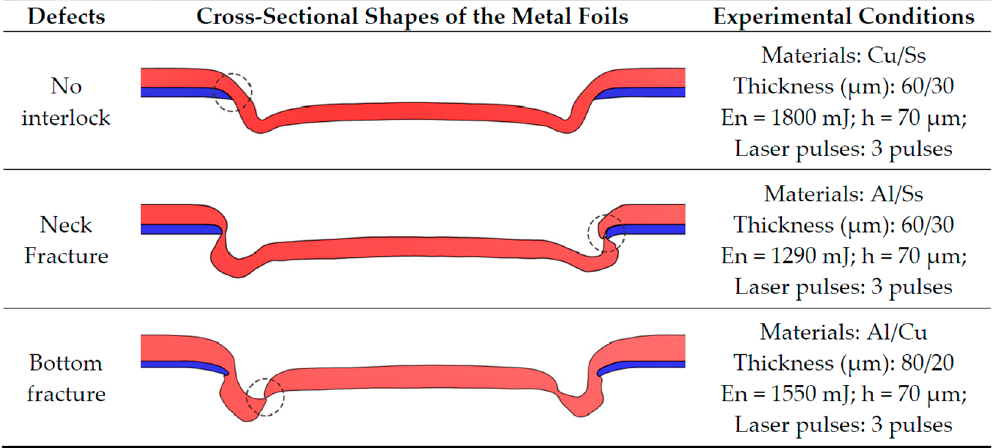
Figure 9. Defects in micro clinching with cutting.